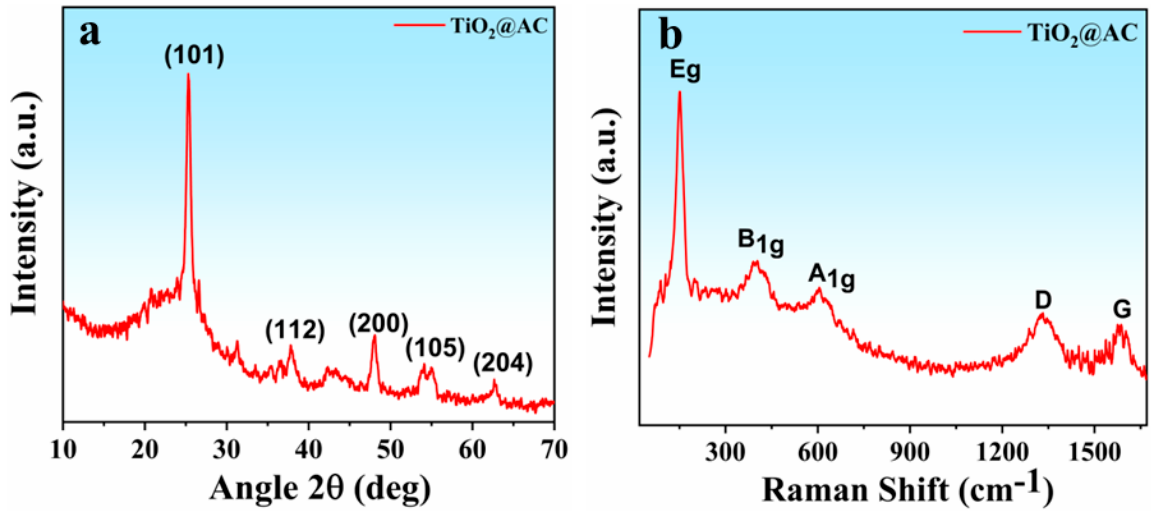
Figure 2. ( a ) XRD spectra of TiO 2 /AC nanocomposites. ( b ) Raman spectra of TiO 2 /AC nanocompo-